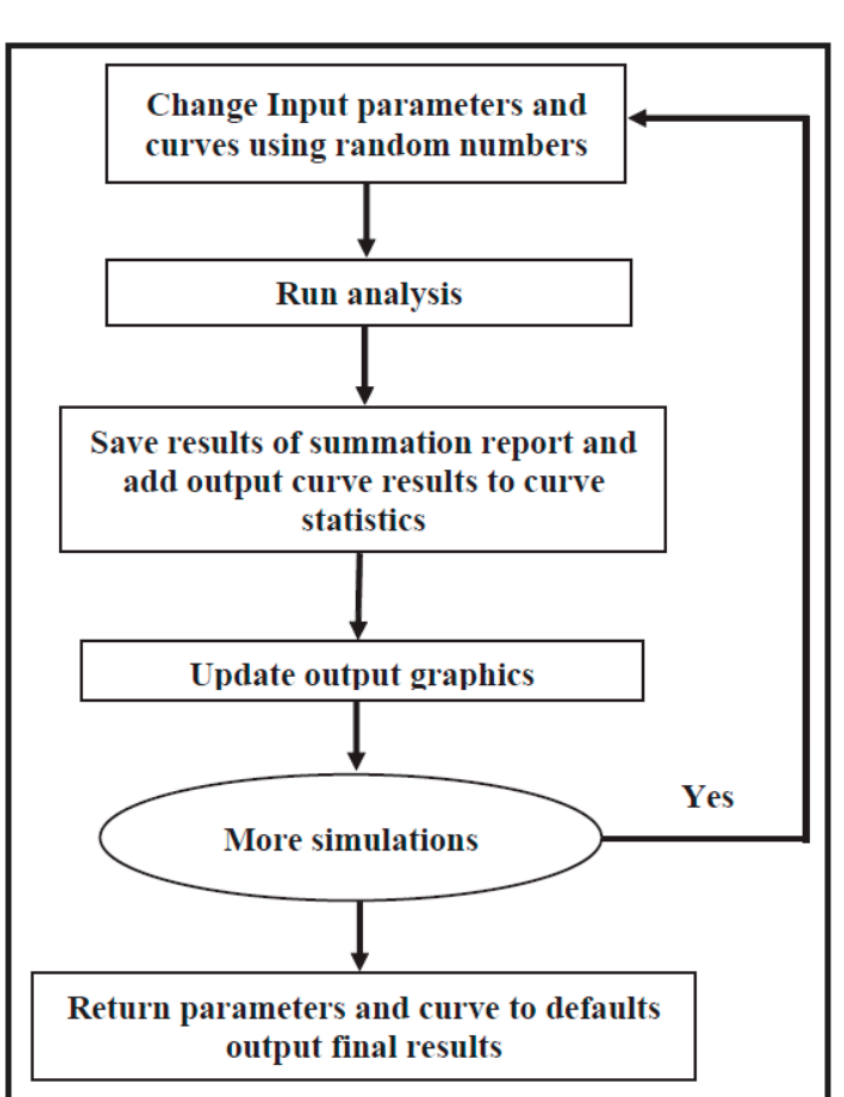
Figure 1. The workflow applied in the uncertainty analysis of petrophysics results.